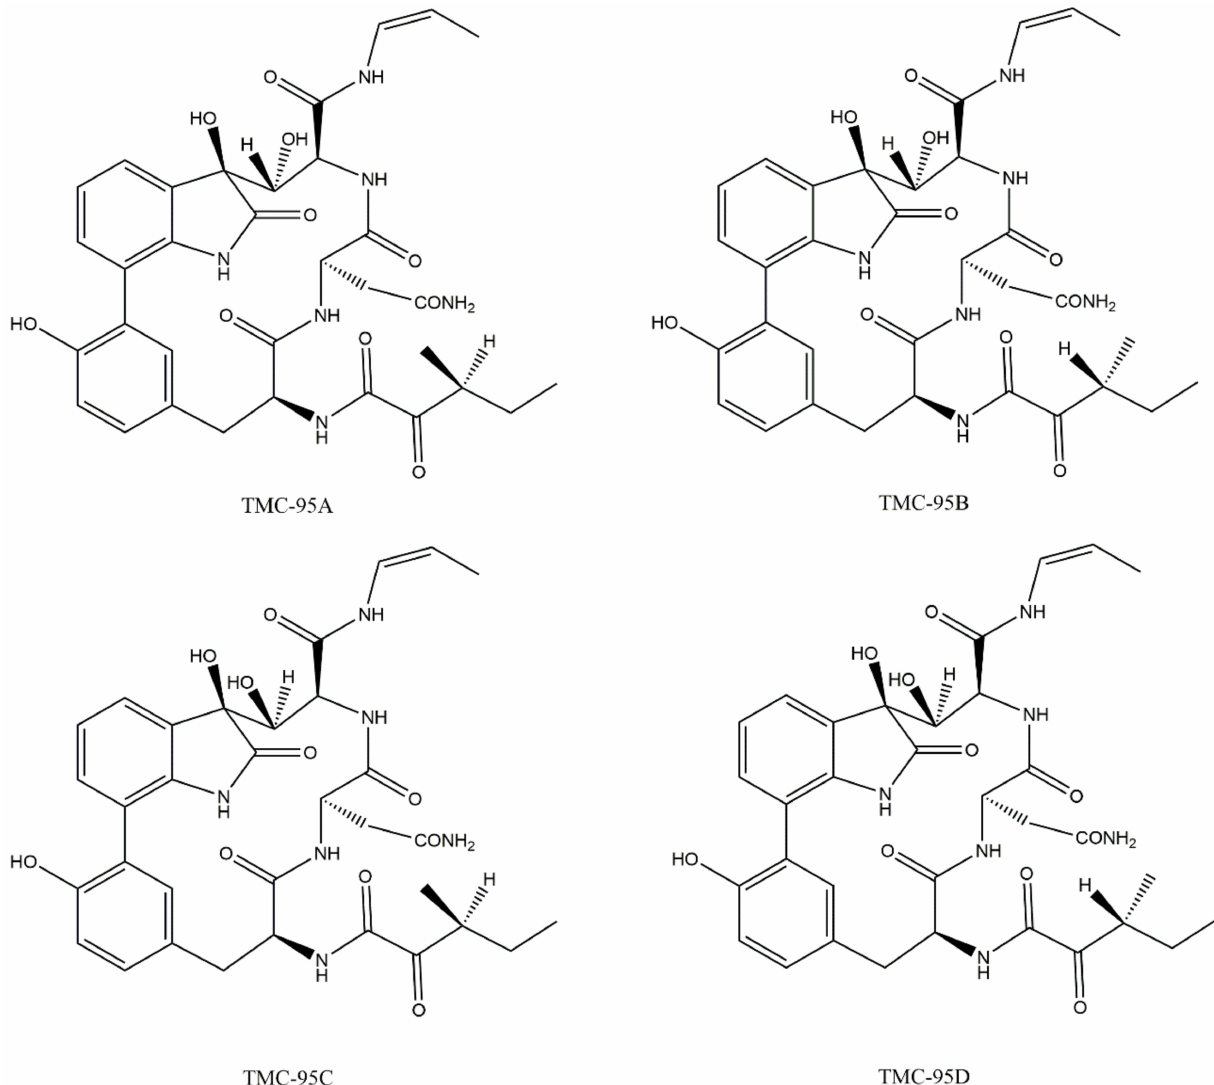
Figure 12. Examples of macrocyclic inhibitors of 20S CP